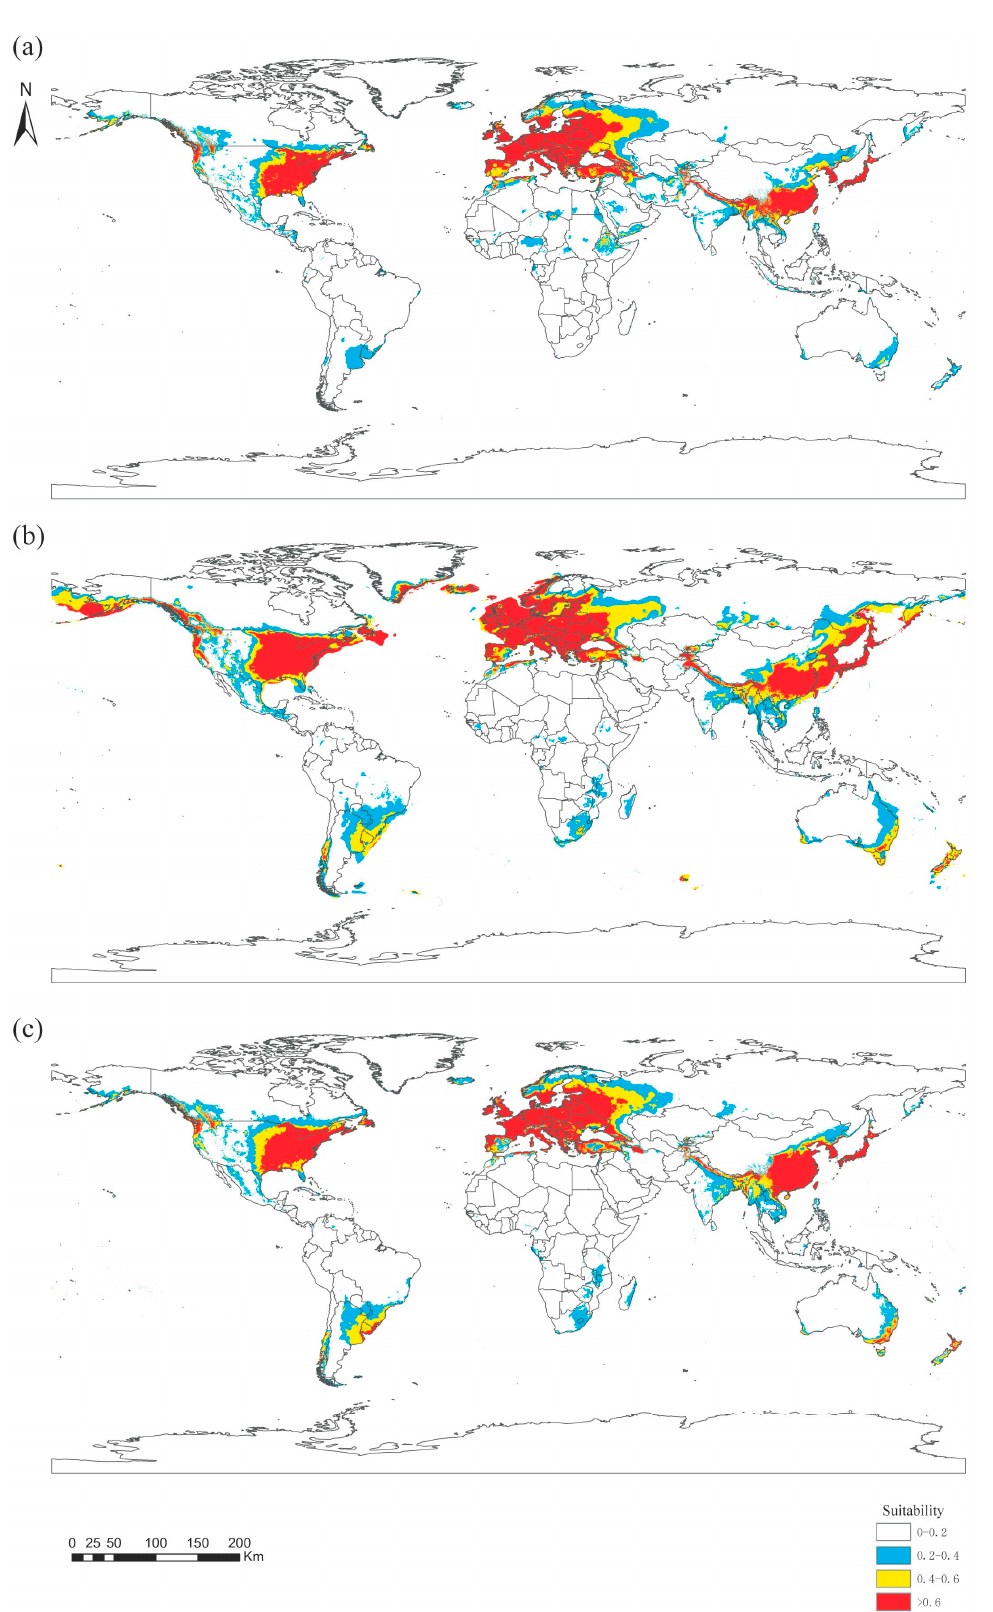
Figure 6. Distribution of the suitable habitat of Panorpidae over three historical periods: ( a ) the Last Interglacial, LIG; ( b ) the Last Glacial Maximum, LGM; and ( c ) 1970–2000, Current.